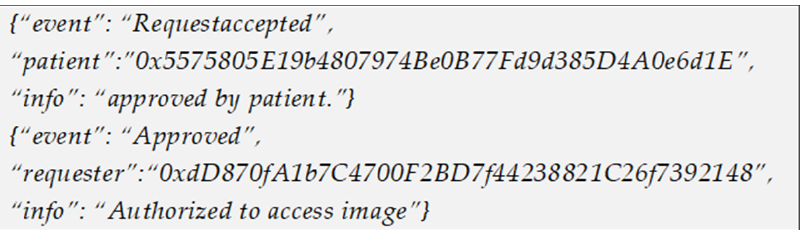
Figure 6. Case 1: event log for approving